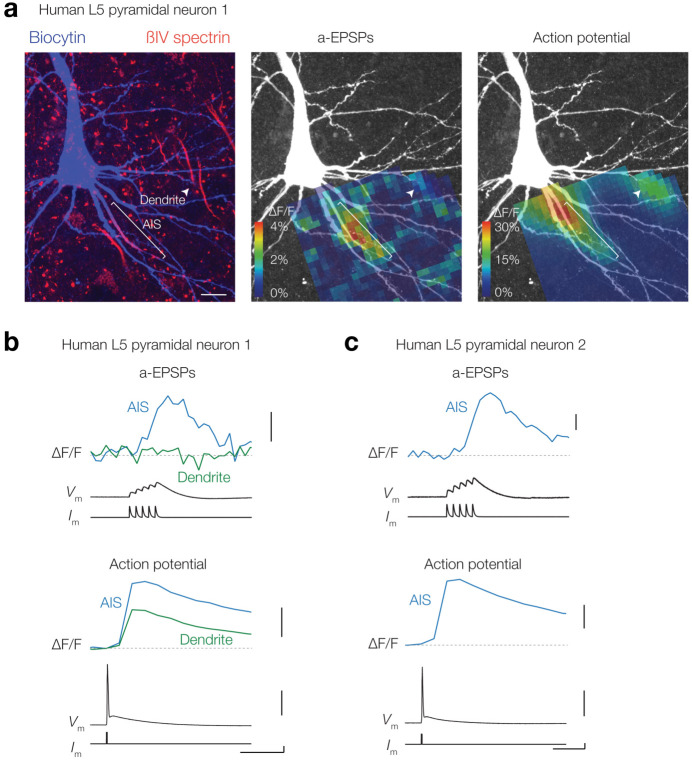
EPSP-evoked evoked Δ[Ca2+]i in human layer five pyramidal neuron AIS.(a) Left, z-projection of a human temporal lobe L5 pyramidal neuron stained with biocytin/streptavidin (blue) and βIV-spectrin (red). Middle and right, peak ∆F/F (OGB-1, 100 μM) in response to an a-EPSP and AP overlaid with a z-projection of biocytin-streptavidin (white) . Note that not all regions visible in the confocal scan (left) are from the same focal plane and thus visible in the ∆F/F plot. The AIS (white line) and a part of a basal dendrite (white arrow) were in focus. Scale bar, 10 μm. (b) Example traces from AIS (blue) and dendrite (green) in response to an a-EPSP (top) and AP (bottom) from locations indicated in a. Note the absence of a-EPSP evoked Ca2+ influx in the dendrite. From top to bottom scale bars, 1% ΔF/F, 10% ΔF/F, 10 mV, 1 nA and 50 ms. (c) Example ∆F/F traces from another neuron AIS (blue) in response to an a-EPSP (top) and AP (bottom). From top to bottom scale bars, 1% ΔF/F, 10% ΔF/F, 10 mV, 1 nA and 50 ms.